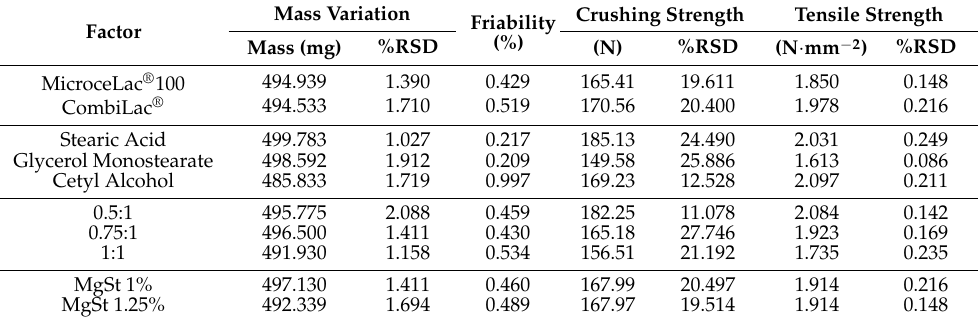
Table 2. Comparison of all formulation factors investigated in the full factorial design, and their corresponding responses per test, presented as an average for mass variation, friability and tensile strength